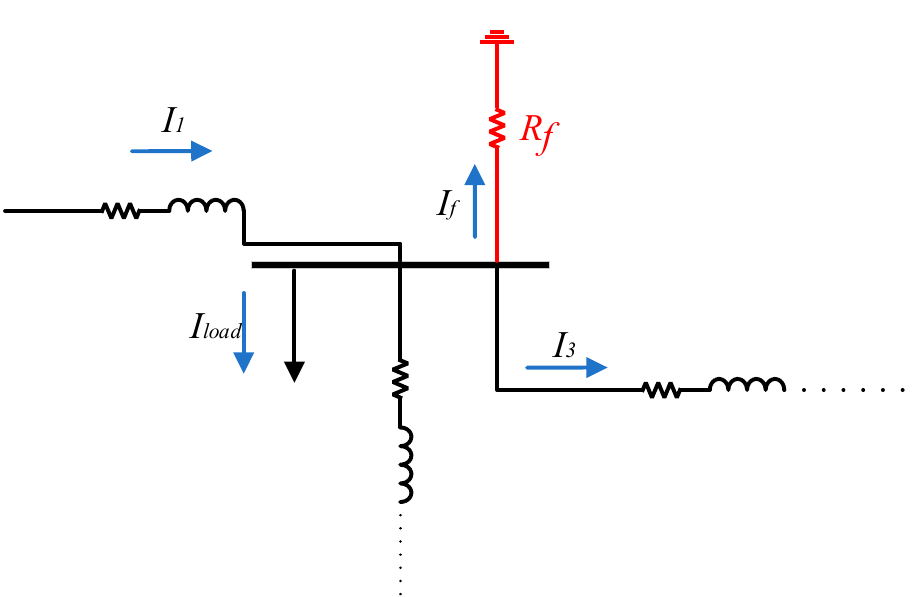
Figure 6. Current distribution during a fault in the distribution system.